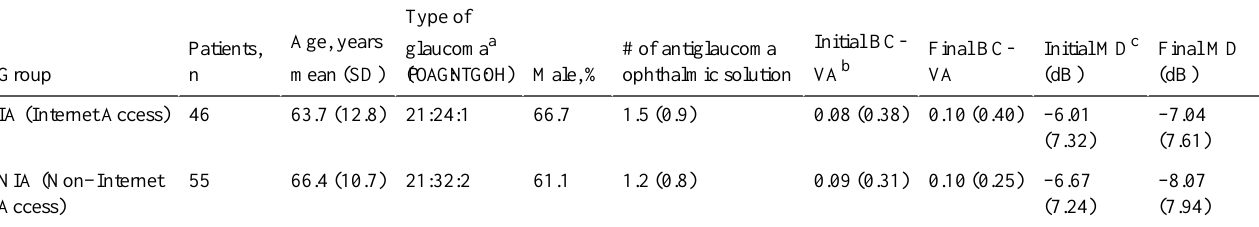
Table 3. Characteristics of patients whose antiglaucoma ophthalmic solution use did not change during the study period (numbers in parentheses are standard